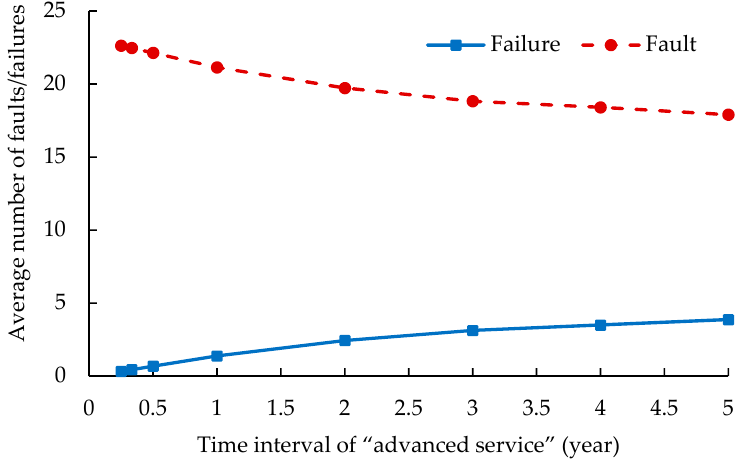
Figure 9. Number of turbine faults and the number of failures causing shutdowns. To understand the trade ‐ off between the availability and maintenance costs, the downtime and the maintenance cost caused by the faults and failures in Figure 9 are cal ‐ culated using the PN model developed. To demonstrate the benefit of taking Measure (2) proposed in Section 1, the downtime and maintenance costs before using the new measure are also calculated for comparison. The results of downtime obtained before and after tak ‐ ing Measure (2) are shown in Figure 10.